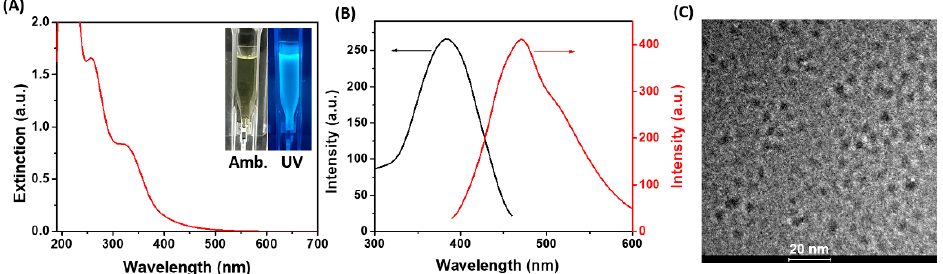
Figure 1. ( A ) The UV-Vis absorption spectrum of His-AuNCs (inset: images of His-AuNCs in colloidal suspension under ambient (Amb.) and UV light). ( B ) The excitation (black line, λ em = 471 nm) and emission (red line, λ ex = 380 nm) spectra of the synthesized His-AuNCs. ( C ) Representative HR-TEM picture of His-AuNCs.